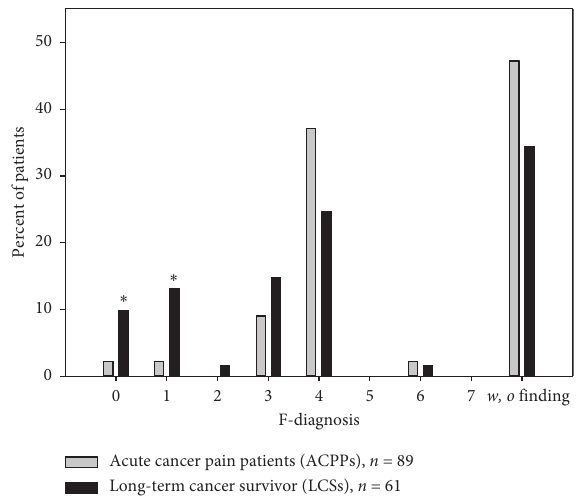
Figure 4: Distribution of psychiatric diagnoses (in percent) in LCS patients (dark bars) vs. ACPPs (light bars). ∗ p � 0 . 007, p ≤ 0 .